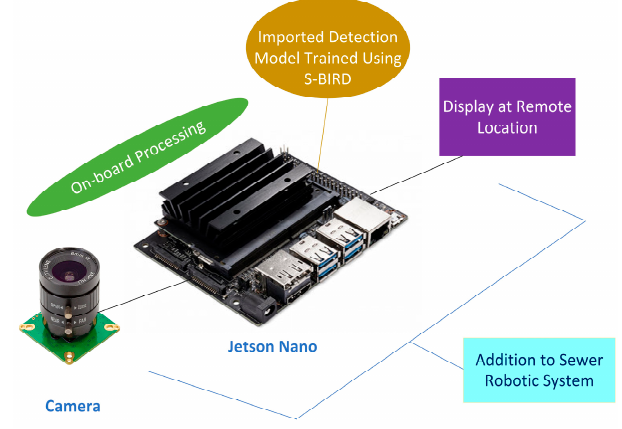
Figure 21. Embedded vision platform for sewer robotic system.